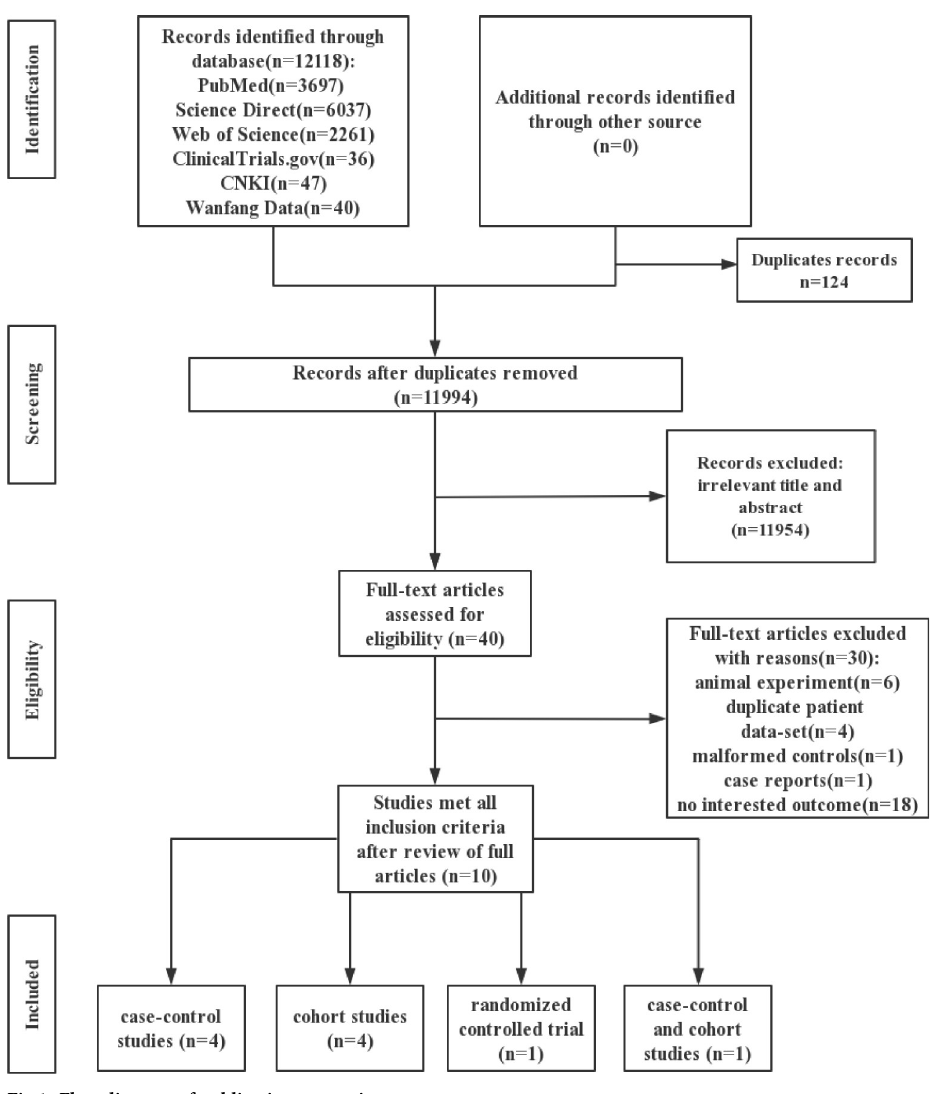
Fig 1. Flow diagram of publications